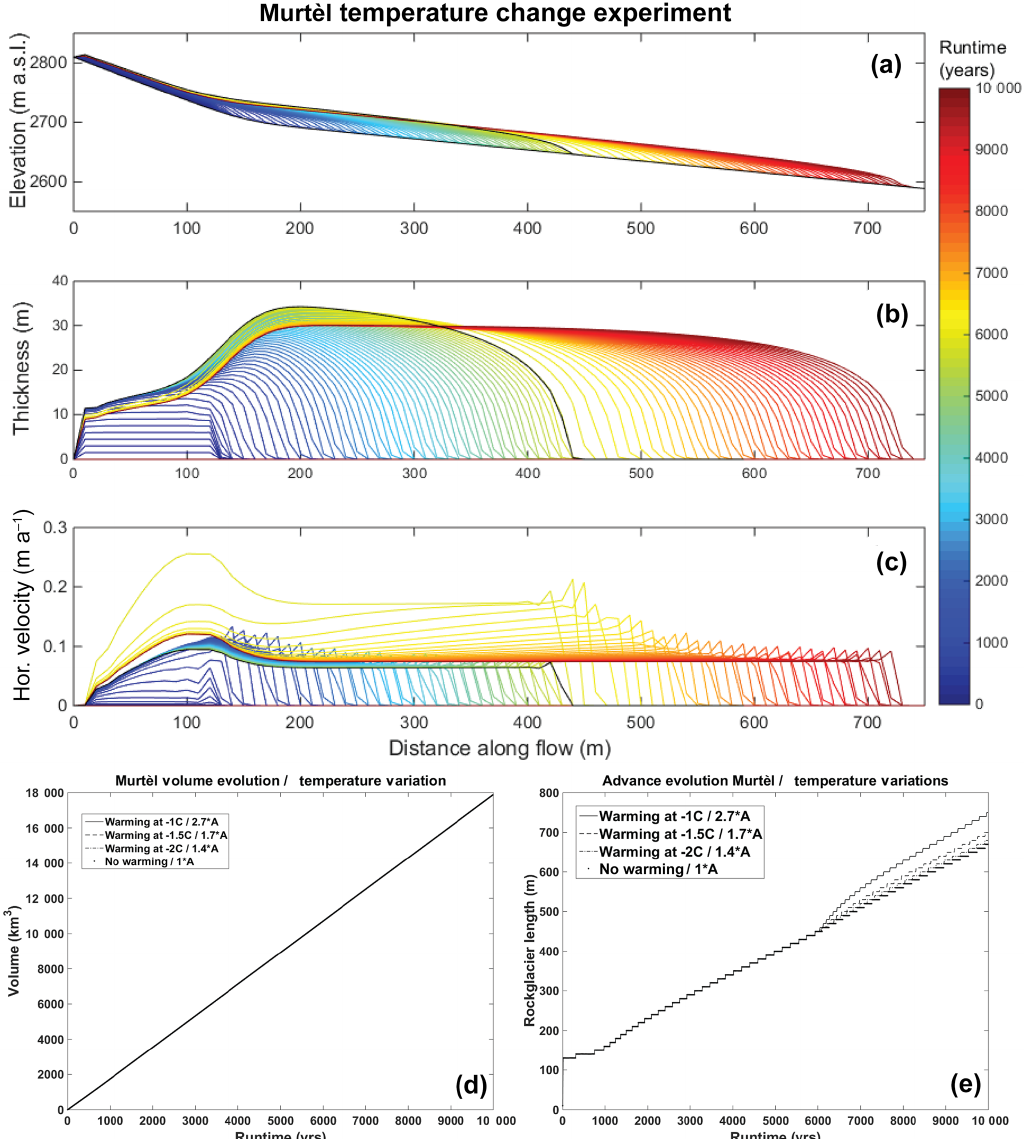
Figure 6. Modeled evolution of surface geometry (a) , absolute thickness (b) , horizontal velocity (c) along the central flow line, terminus advance (d) and volume evolution (e) for the rock glacier buildup (first 6000a runtime) and for the successive temperature perturbation experiment (temperature increase of 1 ◦ C, with − 1.5 ◦ C reference temperature). The black line shows the state of the system before the temperature step change at 6000a. The lines are plotted at 100a time